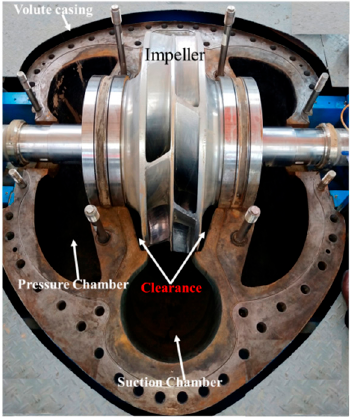
Figure 1. Centrifugal pump.